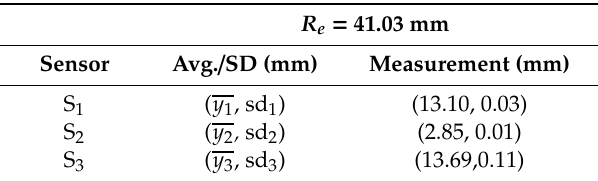
Table 10. Displacements of the inspected part whose nominal radius is priory known R e = 41.03 mm, measured with an accuracy of ± 0.01